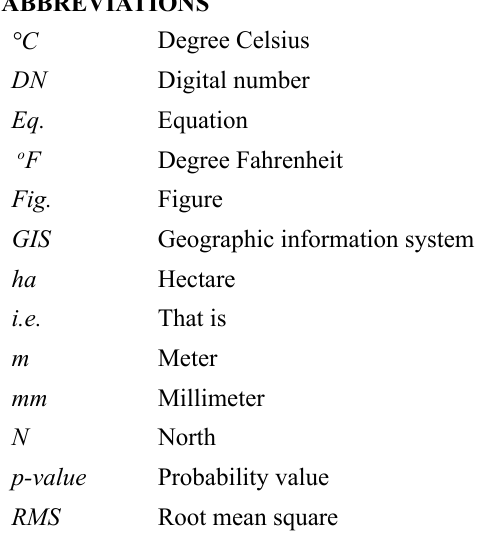
GIS Geographic information